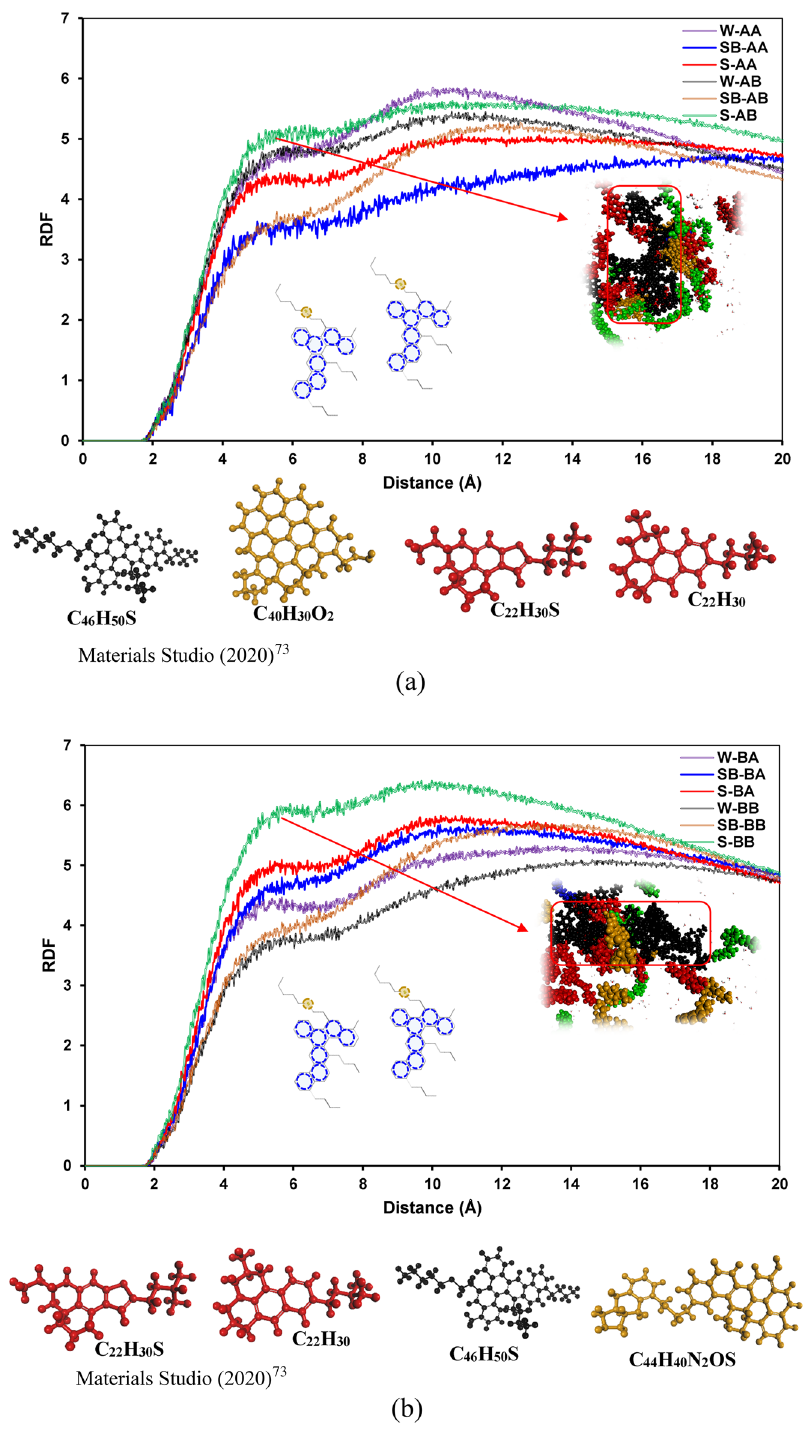
Figure 10. RDF of the aromatic–aromatic molecule pairs containing ( a ) C 40 H 30 O 2 and ( b ) C 44 H 40 N 2